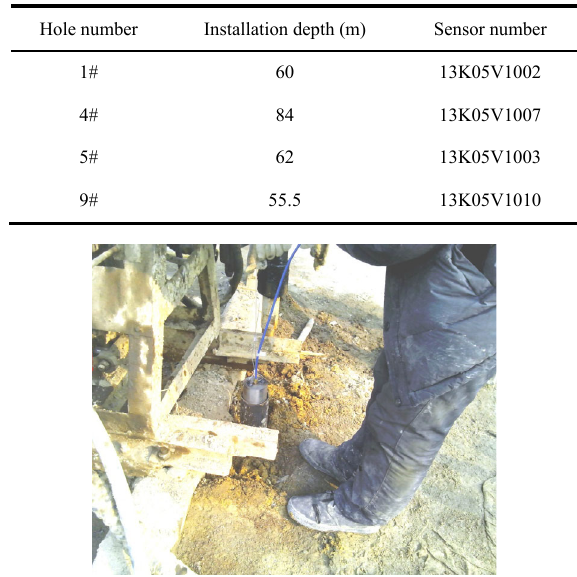
Table 3 Placement information of micro seismic sensors.